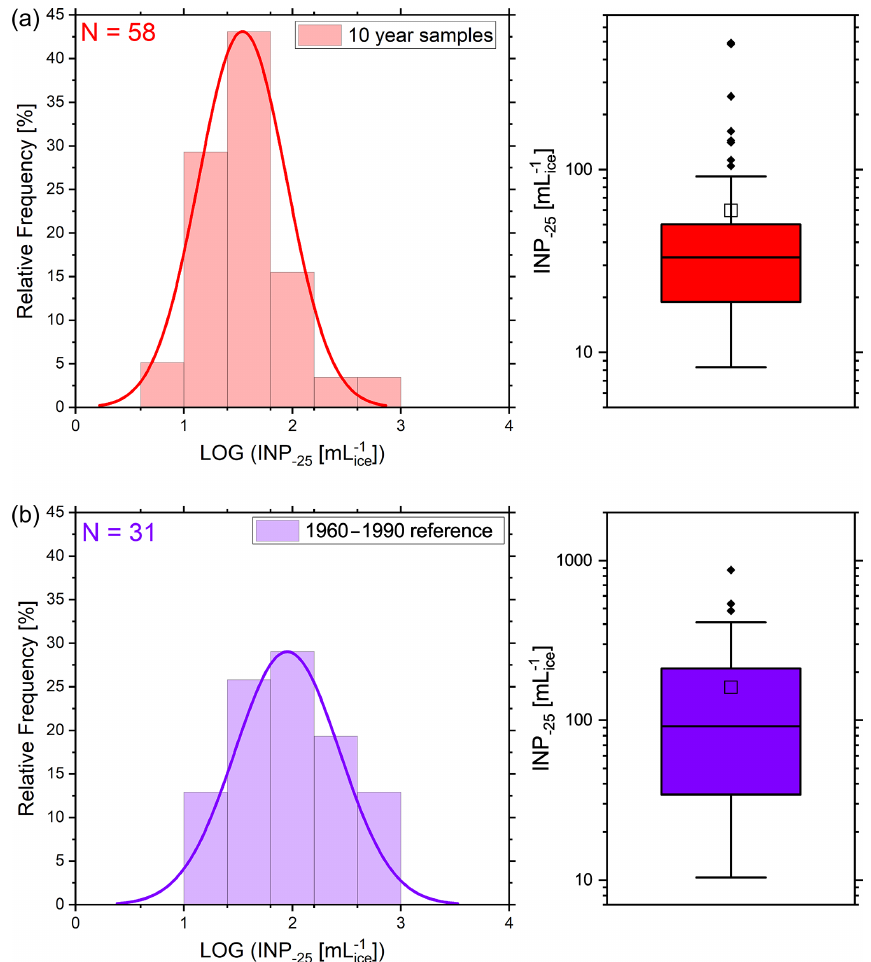
Figure 10. Empiric probability density function (bars) of the logarithmic INP concentration at − 25 ◦ C of the 10-year samples (a) and the modern-day samples (b) . The data follow a lognormal distribution (fitted curve). The right panel shows the corresponding box–whisker